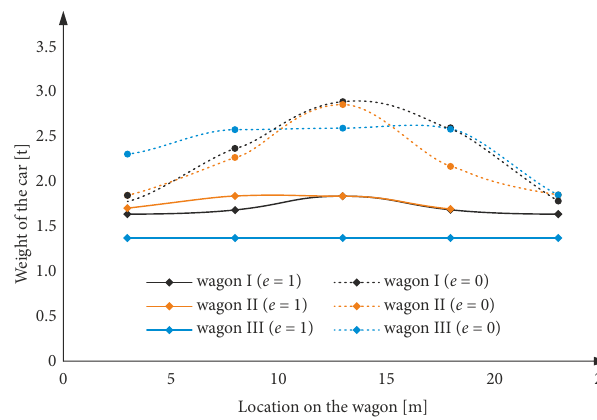
Figure 2. 6 loading curves about the case